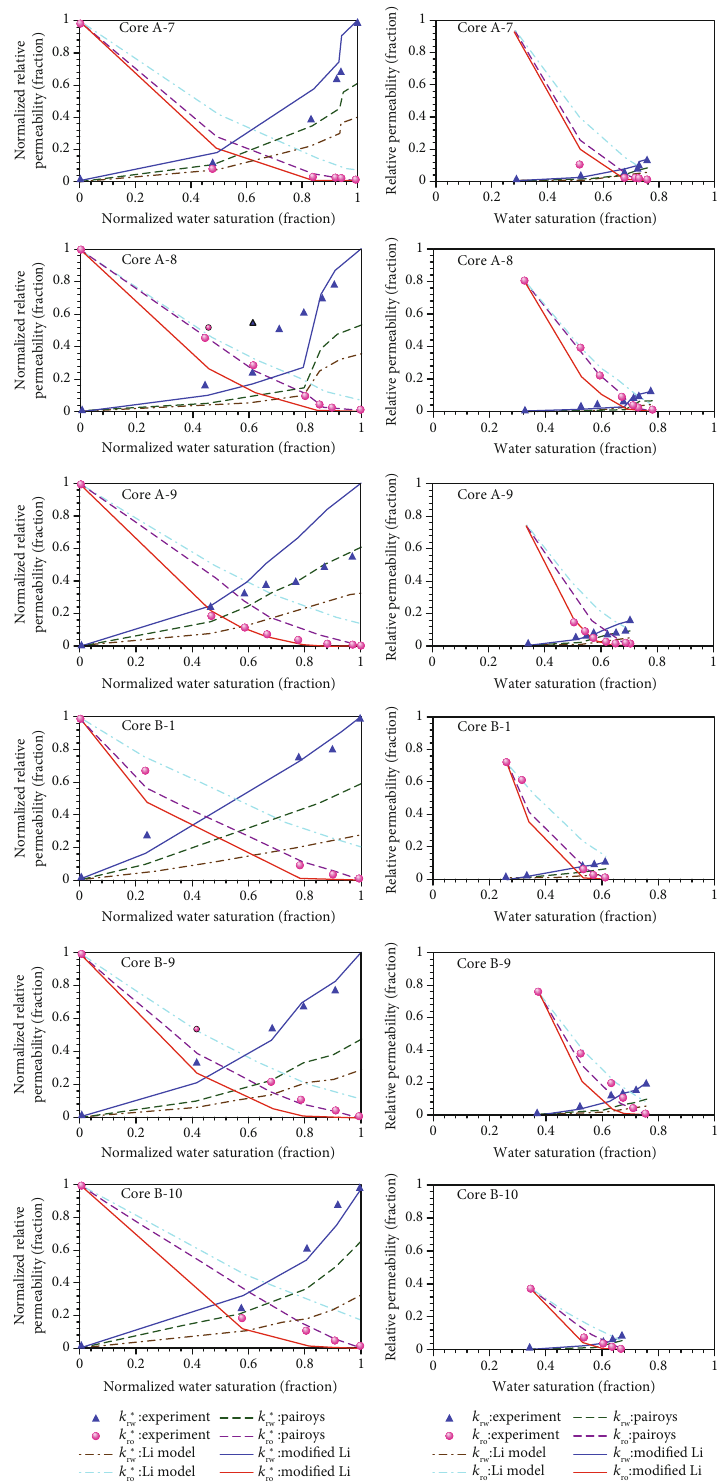
Figure 7: Comparison of relative permeability curves in sandstone ity. Core samples are divided into two groups. Group I (Figure 6). The resistivity and relative permeability of core contains less clay and smaller Q v than group II. The basic samples with di ff erent water saturations were measured. Core samples from Wells A and B are tested to explore physical parameters of cores are shown in Table 1. The the relationship between resistivity and relative permeabil- salinity of formation water in wells A and B are